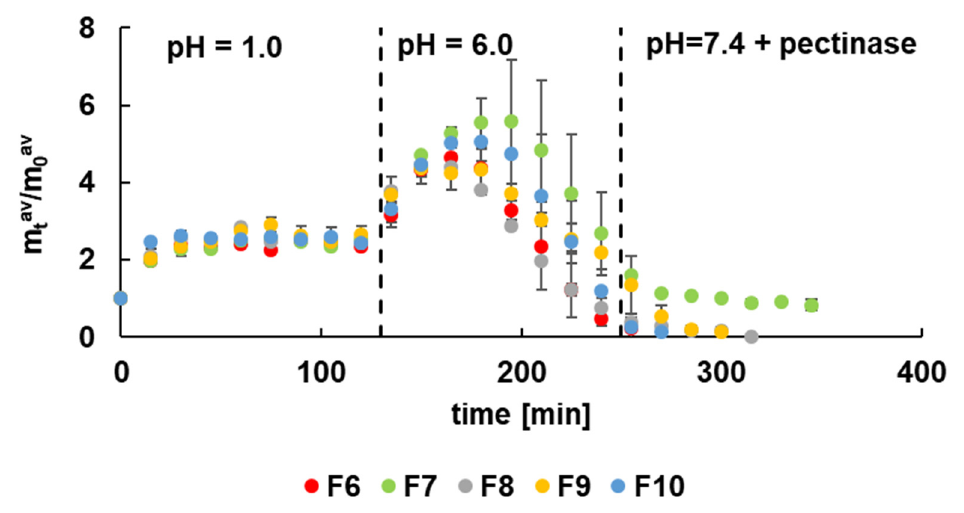
Figure 3. The dependence of the carrier mass of formulations F6–F10 in time at different pH.